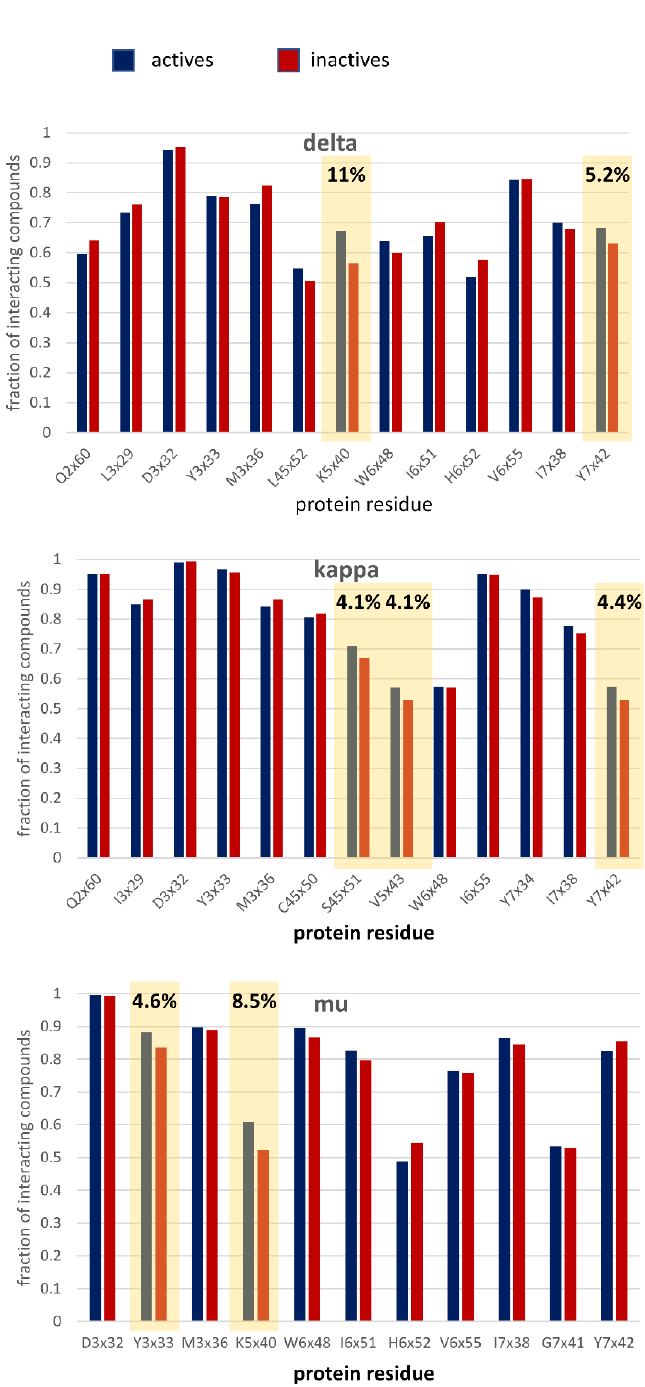
Figure 6. Histograms of the frequencies of interactions of compounds with particular amino acids (only positions with interaction frequency above 50% are shown, the formation of any contact is considered). Positions with the highest difference between active and inactive compounds are indicated.